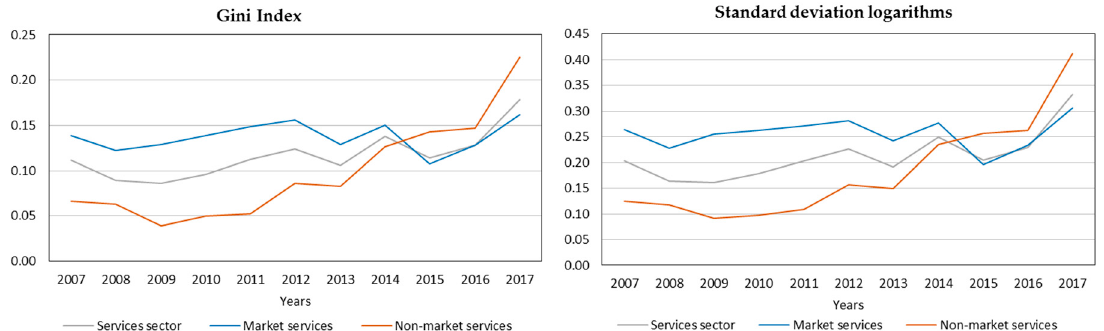
Figure 4. Gini index and standard deviation of provincial productivity in Ecuador, period 2007–2017. Source: Own elaboration based on the Regional Accounts of the BCE [46]; ENEMDU surveys from the INEC [47] (several years) and Distributive Analysis Stata Package (DASP).